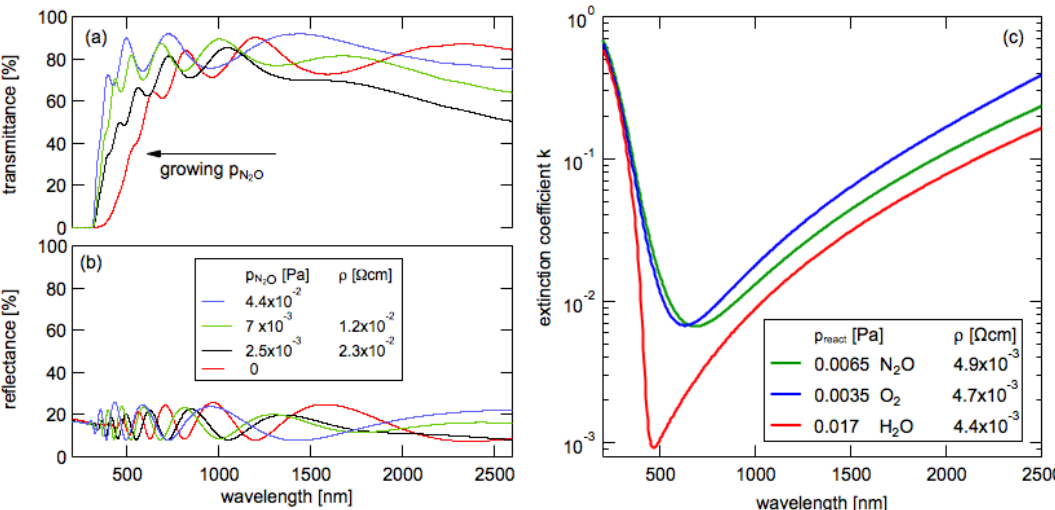
Figure 10. ( a ) Transmittance T and ( b ) reflectance R spectra in the wavelength range from 200 to 2600 nm of SnO 2 :Ta films, deposited at different N 2 O partial pressures. ( c ) Spectral extinction coefficients of 3 SnO 2 :Ta films, deposited with different reactive gases and nearly the same minimum resistivity of about 4.7x10 − 3 Ω cm. Deposition parameters: P RF = 100 W, 0.5Pa, RT.